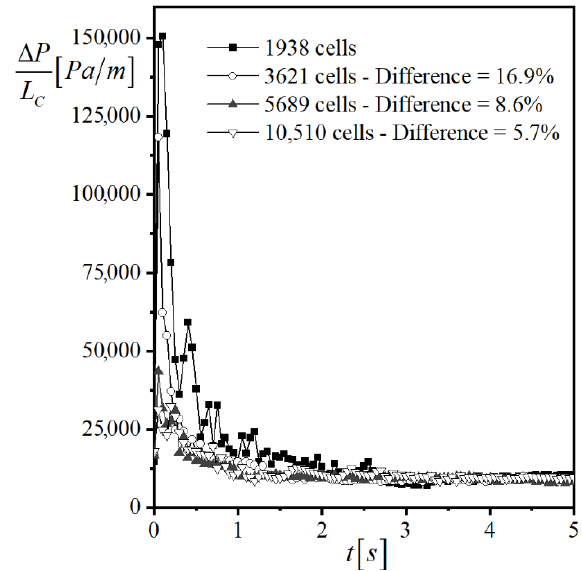
Figure 3. Sample of the mesh independency analysis, considering the pressure drop per unit length as metric, for a spouted bed packed with 2 mm glass beads, H σ ,0 = 160 mm and